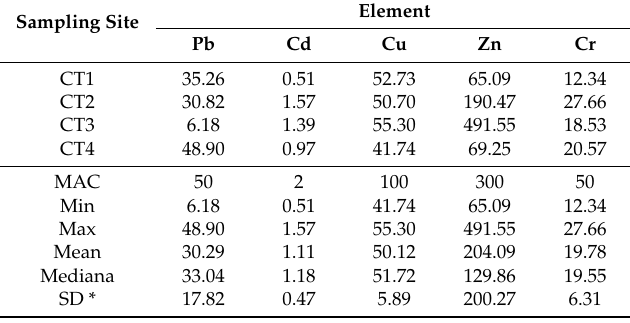
Table 7. Total contents and descriptive statistics of elements in Cetinje (CT) urban parks soil samples for this study (mg ¨ kg ´ 1 ).